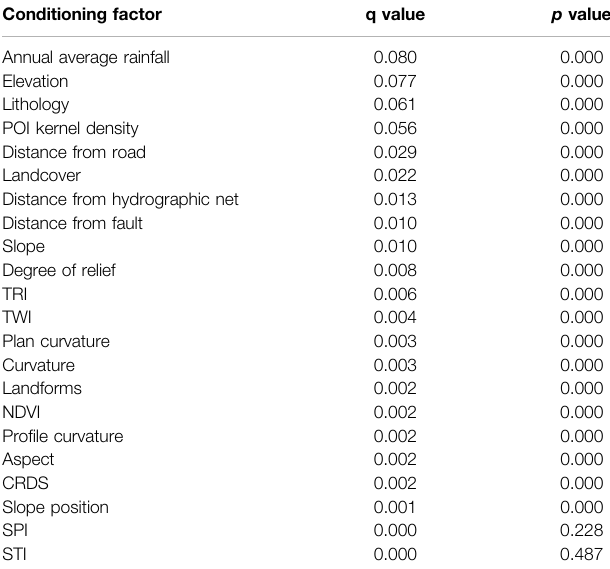
TABLE 2 | Factor detector results. Conditioning factor q value p